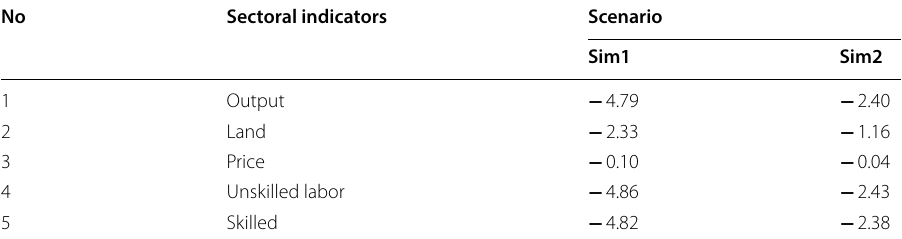
Table 4 Impact of stoppage of palm oil exports to the European Union based on sectoral conditions in